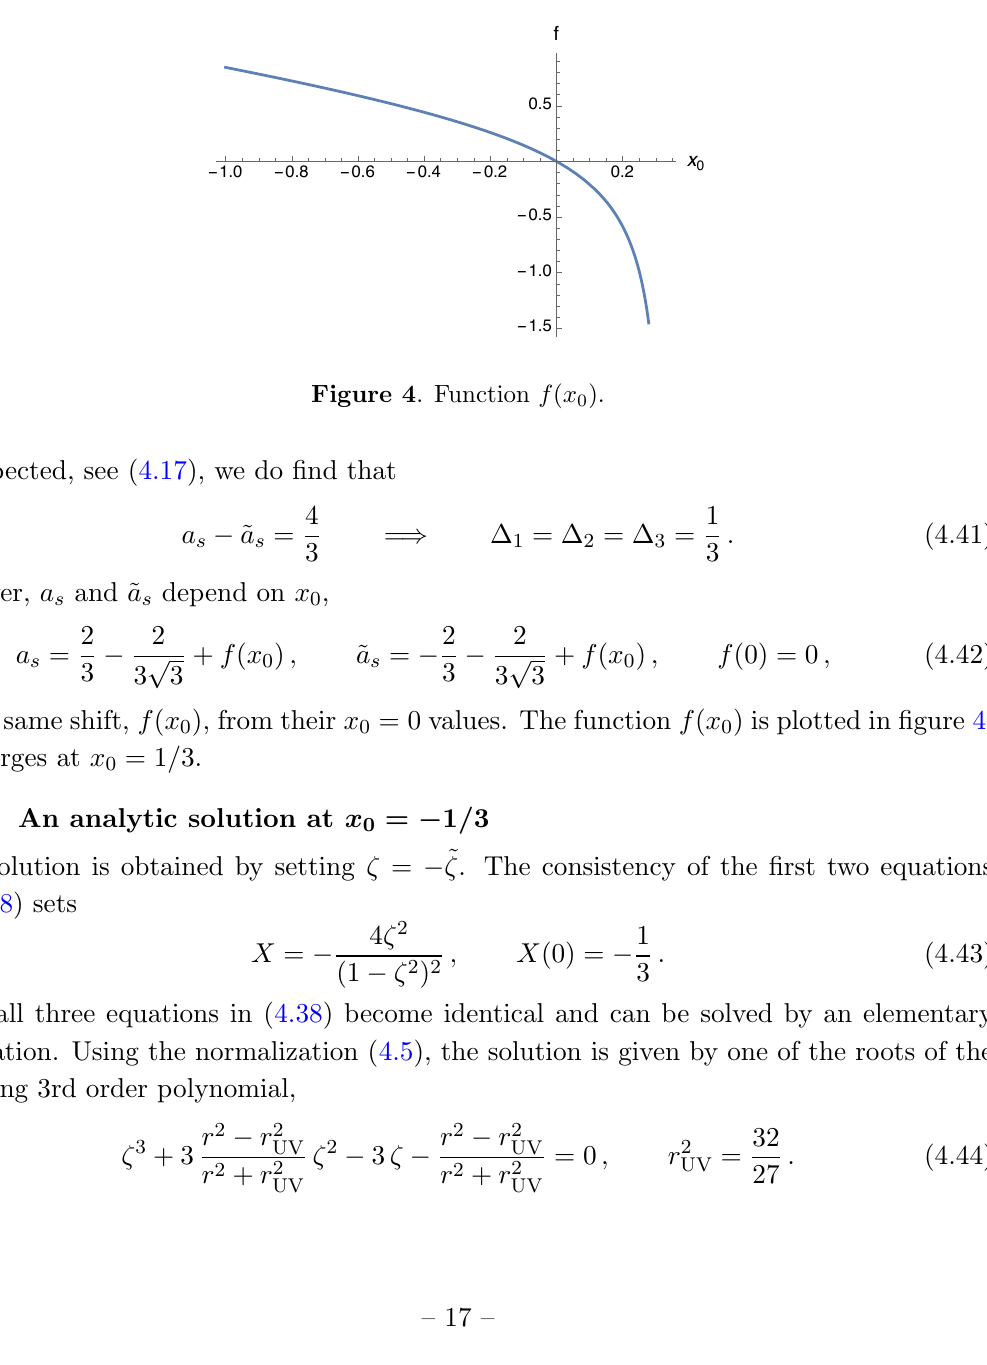
Figure 3 . Function r UV ( x 0 ) obtained by interpolation from numerical solutions. The blue dots on the right are the data points close to x 0 = 1 = 3. The red dot denotes r UV (1 = 3).